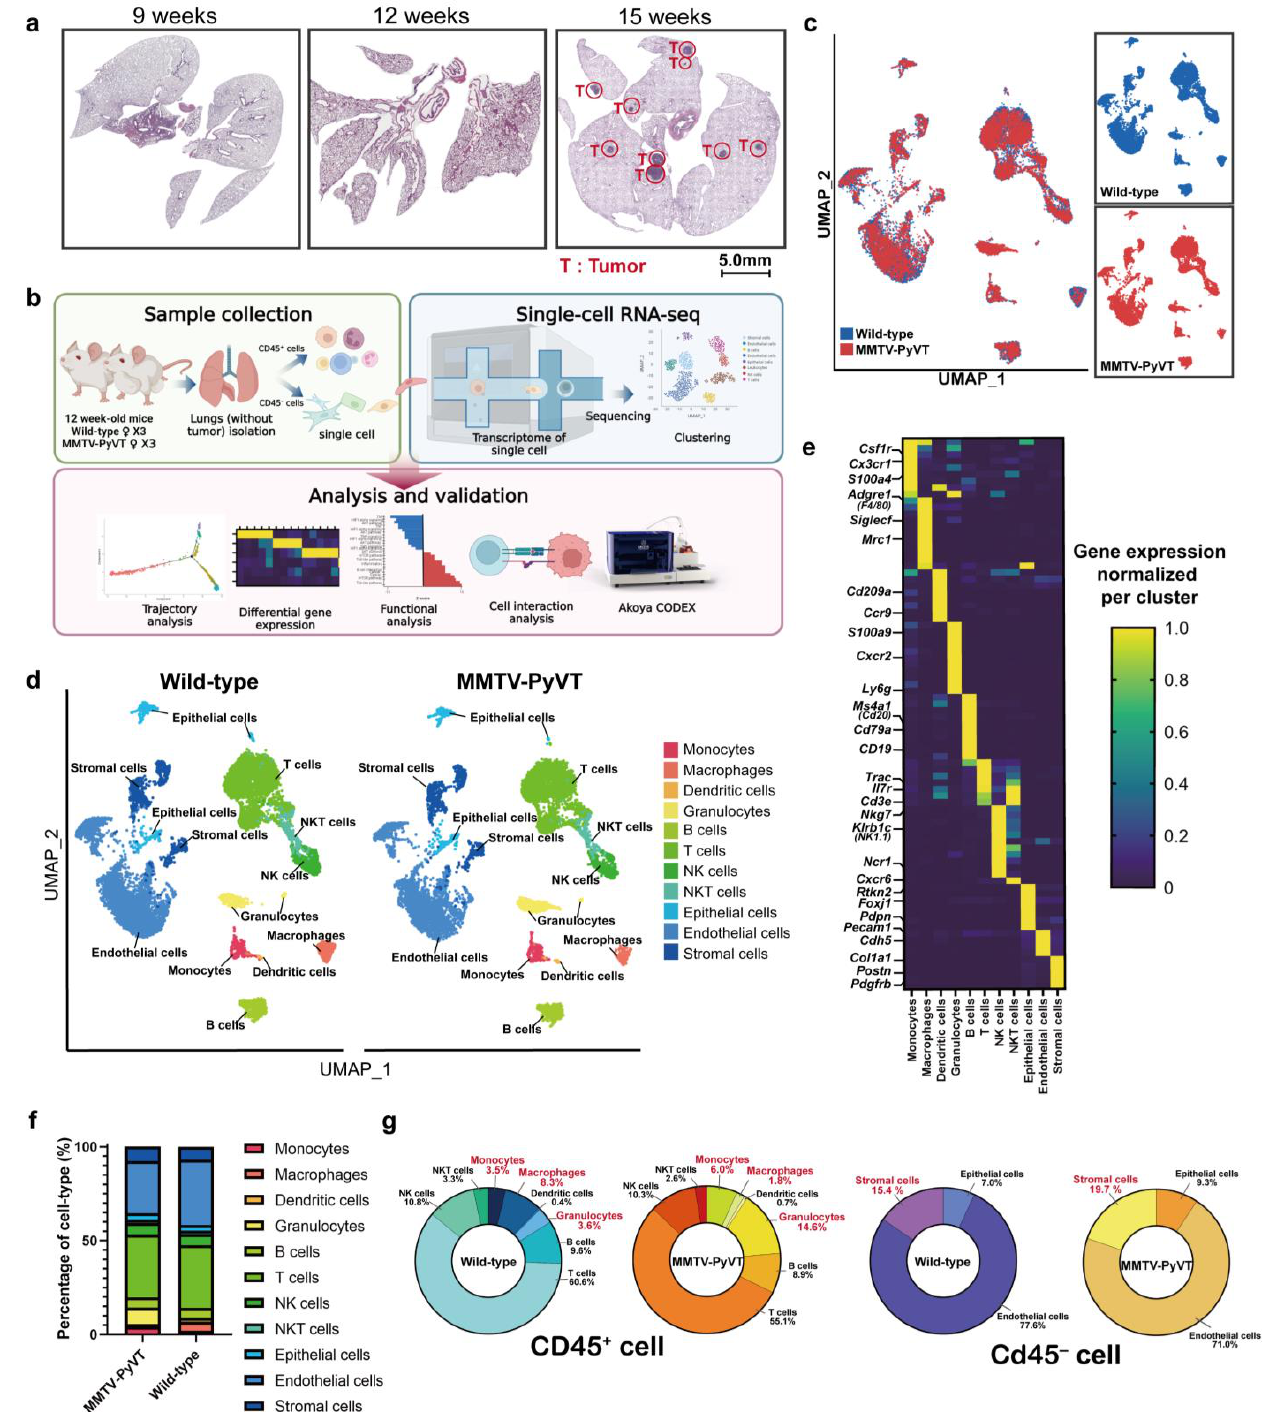
Figure 1. Transcriptome atlas of the lung pre-metastatic niche in MMTV-PyVT mice with primary breast cancer. ( a ) HE staining of lungs in wild-type and MMTV-PyVT mice. The lungs were collected from wild-type and MMTV-PyVT mice with primary breast cancer at 9, 12 and 15 weeks of age ( n = 3). ( b ) Experimental flowchart. ( c ) Blueprint of the scRNA-seq of the lung. ( d ) Cell clusters of the lungs of wild-type and MMTV-PyVT mice. UMAP representation of the lungs of wild-type and MMTV-PyVT mice. ( e ) Markers of cell clusters. ( f ) Cell number of each cell cluster. ( g ) Pie chart for the percentage of Cd45 + and Cd45 - cells.